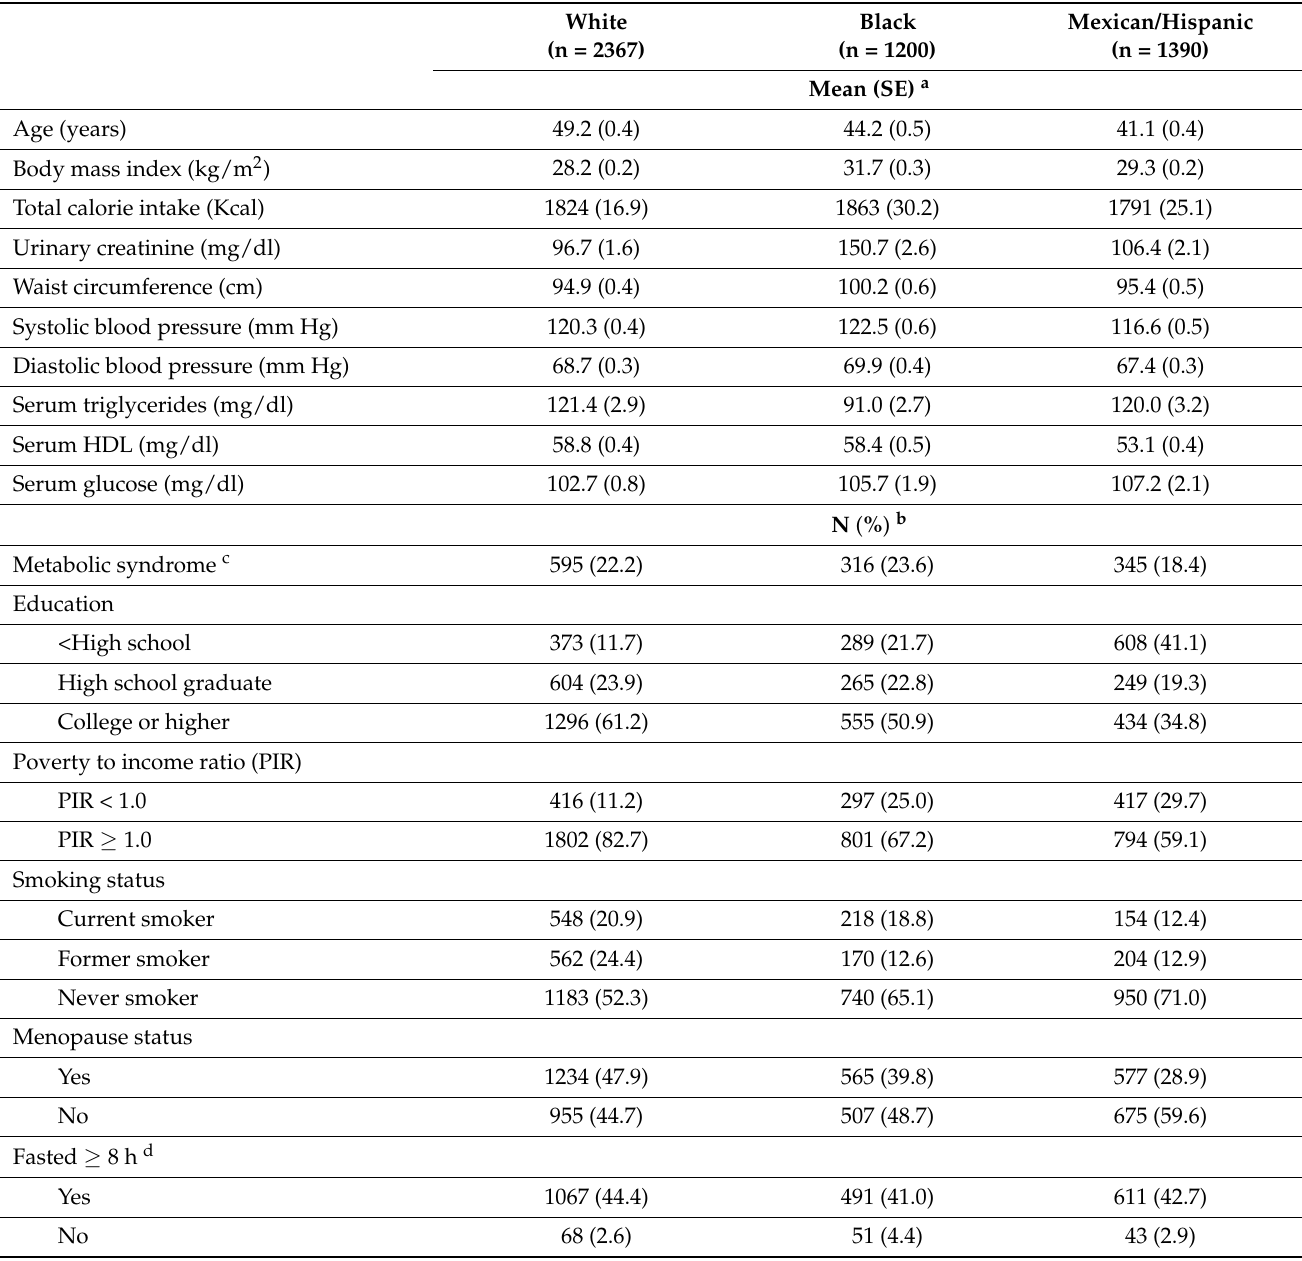
Table 2. Demographic and metabolic characteristics among women, NHANES